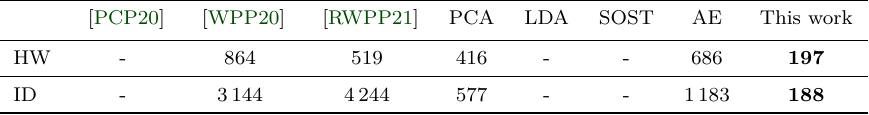
Table 4: Benchmark the attack performance ( T GE 0 ) with the ASCAD_R dataset.